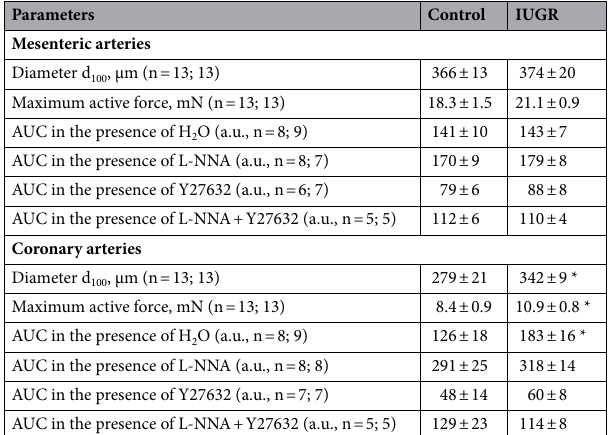
Table 1. Blood serum levels of energy substrates in adult rats from control and IUGR groups. Numbers in parenthesis indicate the numbers of animals.